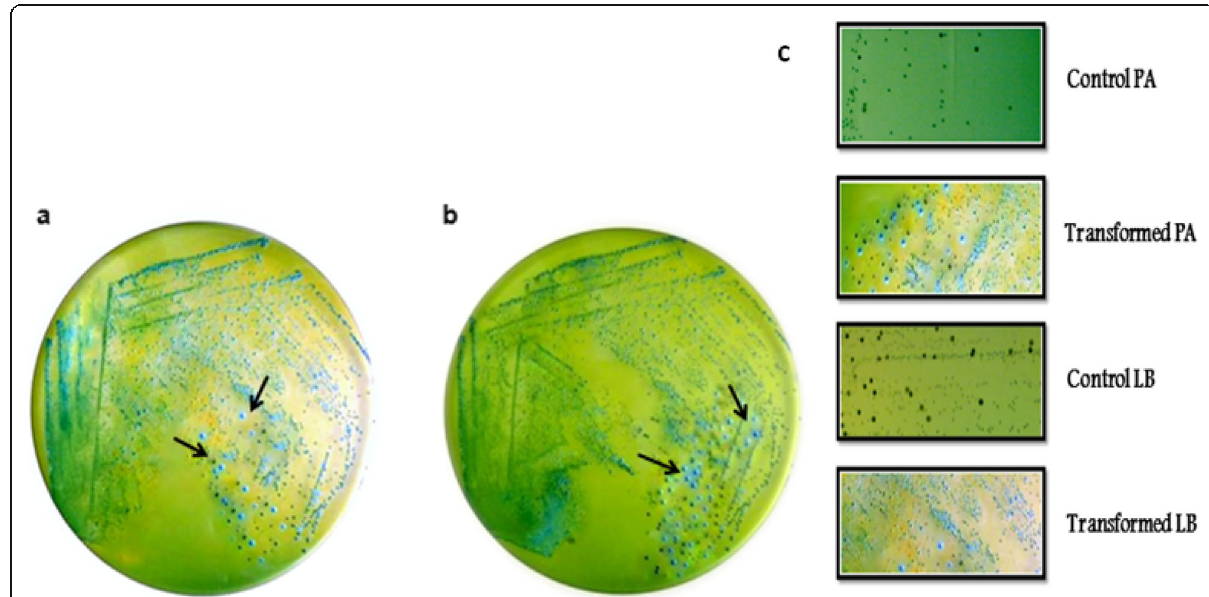
Fig. 7 Bile salt hydrolase plate assay showing white precipitates around BSH + colonies marked by arrows. a P. acidilactici MTCC 5101. b L. brevis